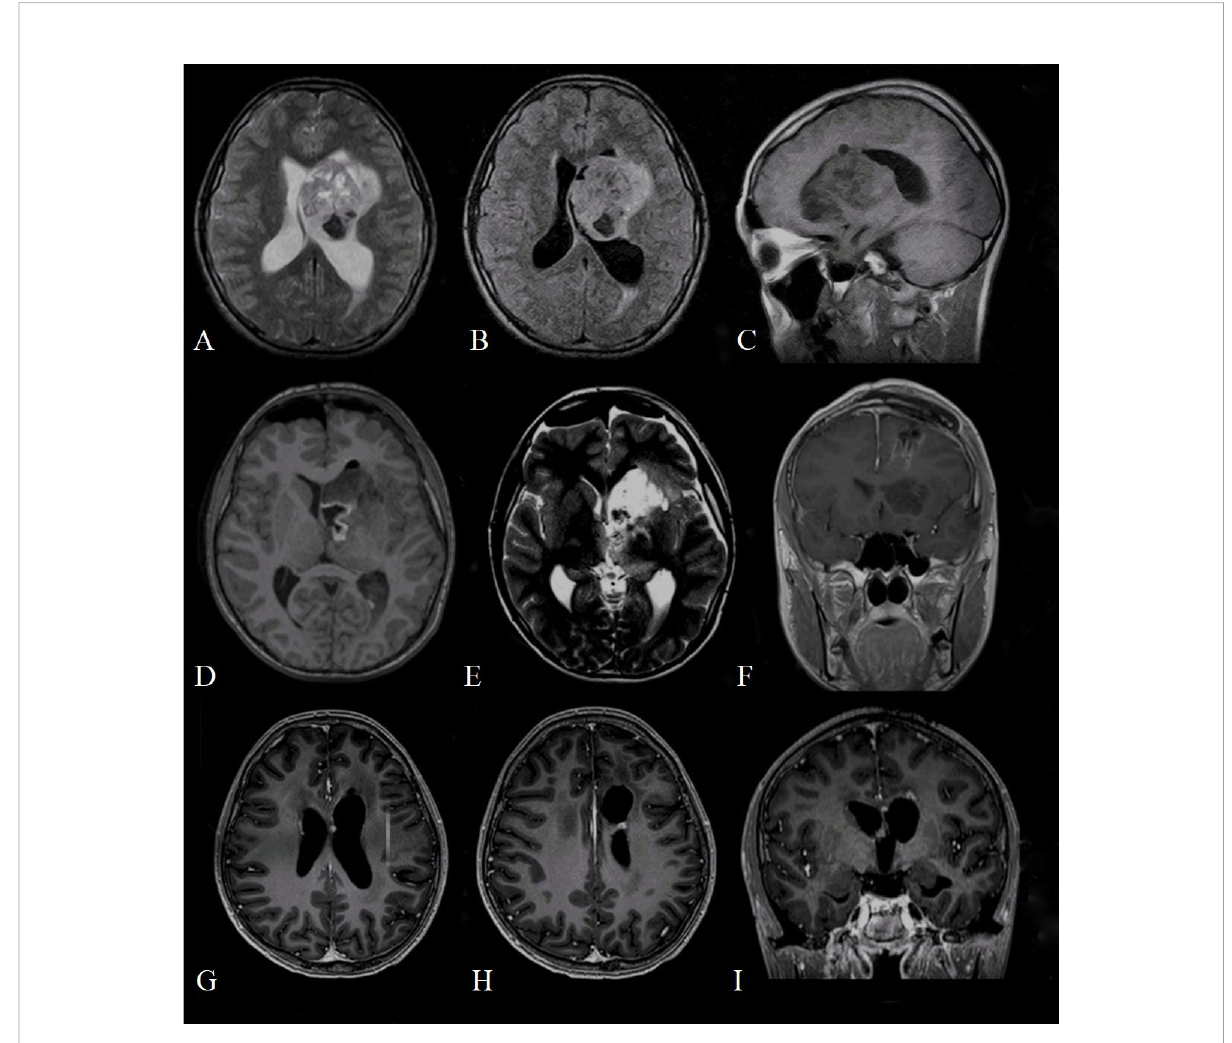
FIGURE 1 Preoperative (A) T2 axial magnetic resonance imaging (MRI); (B) T2 FLAIR axial MRI; (C) T2 sagittal MRI demonstrating mass in the left lateral ventricle with heterogeneous enhancement measuring 7.2 cm x 4.7 x 5 cm, composed of both cystic and solid areas, and extending to the frontal lobe of the brain; Postoperative (D) T1 axial magnetic resonance imaging (MRI); (E) T2 weighted image axial MRI; (F) T1 contrasted coronal MRI demonstrates the area of postoperative cystic change and residual tumor measuring 1.3 cm x 1.1 x 1 cm, actively accumulating contrast agent; contrasted T1 axial (G, H) and coronal (I) MRI at 17-month follow-up, which shows residual tumor measuring 4.5 x 3.2 mm (H) and 4.3 x 2.6 mm (G)